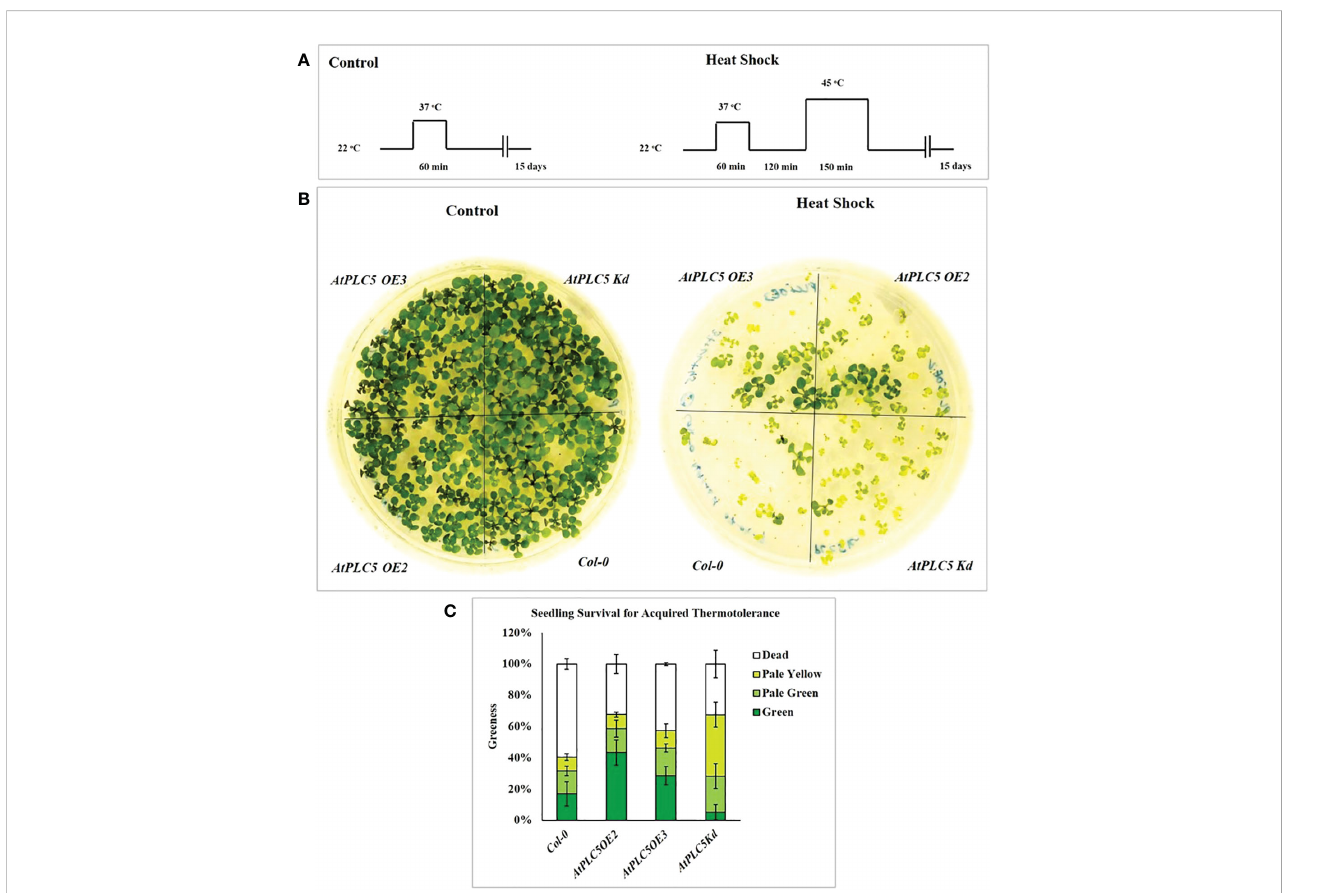
FIGURE 1 Seedling survival assay for acquired thermotolerance. (A) Schematic diagram of the heat shock conditions used to assess acquired thermotolerance phenotypes of AtPLC5 mutants of Arabidopsis thaliana. Three days old seedlings were prior acclimatized by subjected to heat stress at 37 °C for 1 h, at 22 °C for 2 h (for recovery) and then exposed to 45 °C for 0 h (control) and 2.5 h (heat shock). Seedlings of mutants were daily monitored for 15 days after treatment. (B) Survival was observed and scored based on seedling leaves color. (C) Mean derived from 4 replicates, containing 34 seedlings for each genotype tested. Error bar represent standard deviation of the mean. Experiment was repeated 3 times independently. Data was represented in